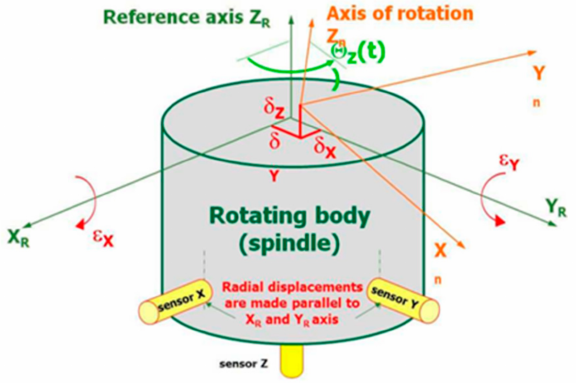
Figure 2. The method of error movements measurement [4].